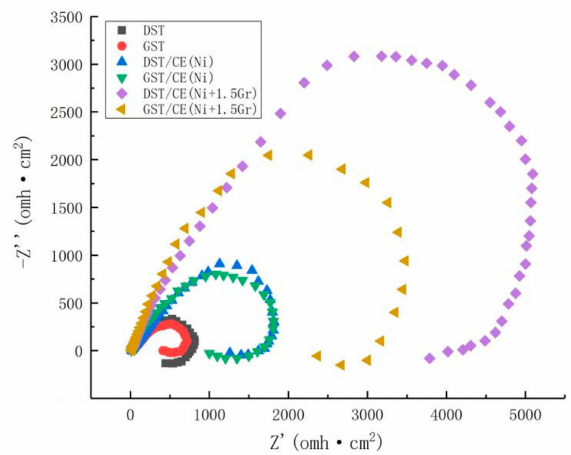
Figure 10. Electrochemical impedance of specimen obtained under di ff erent